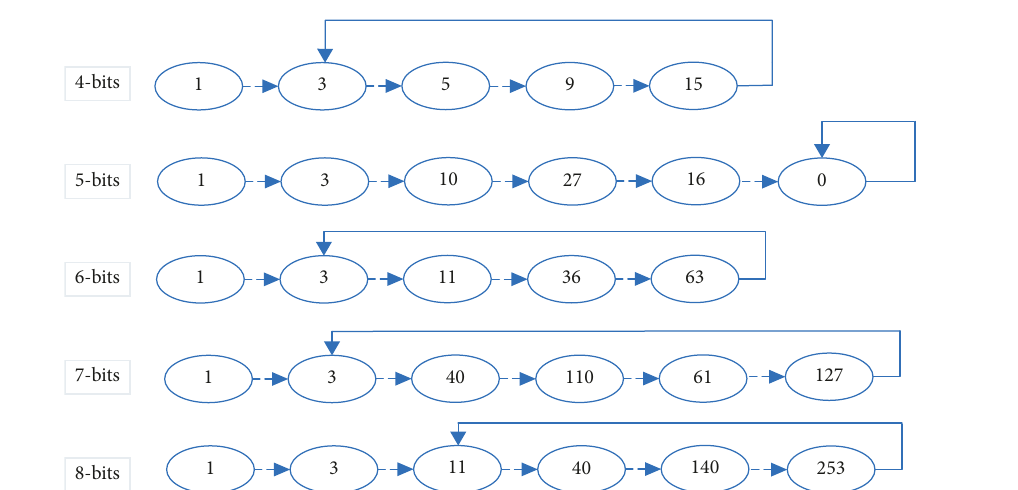
Figure 4: Periodicity with the same initial value x